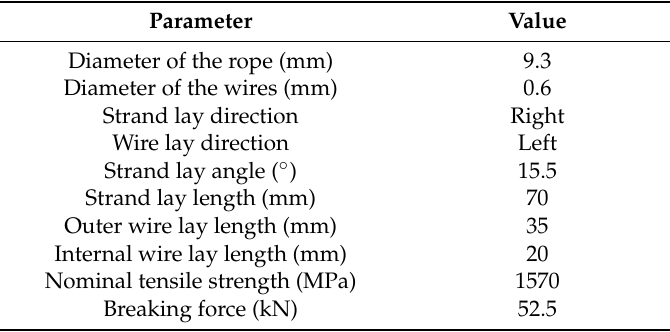
Table 1. Parameters of the steel wire rope